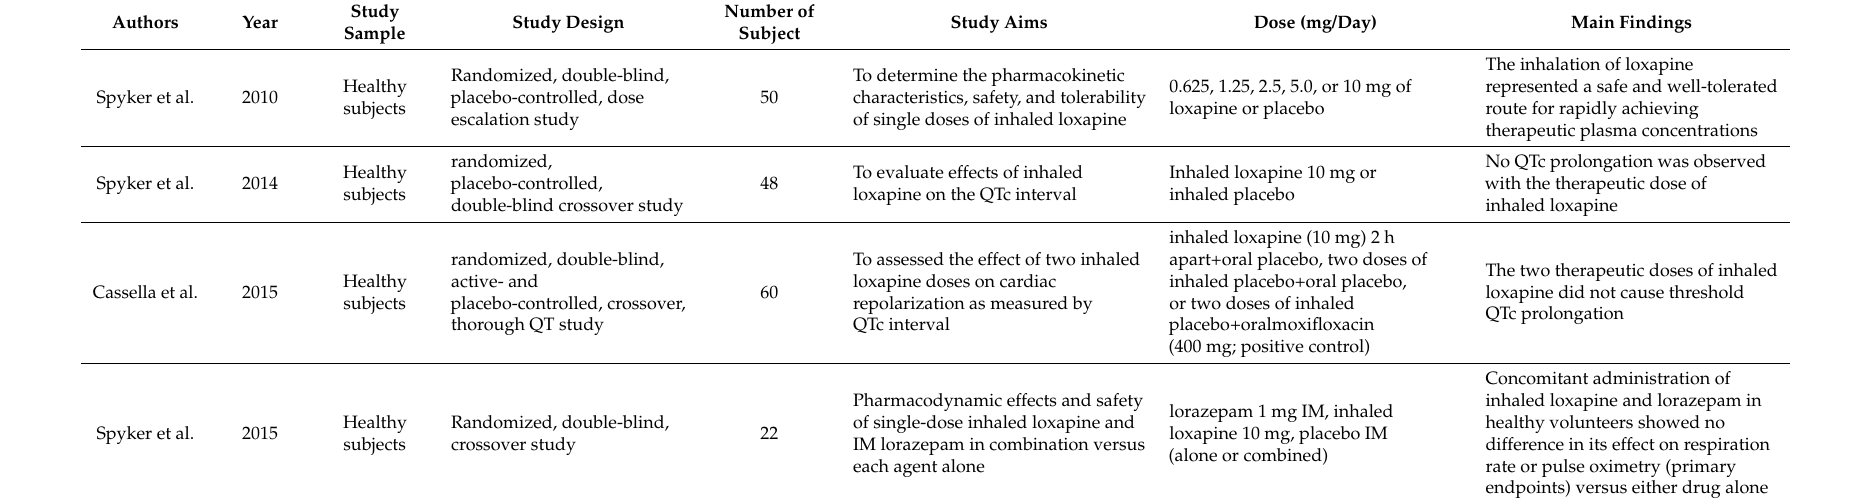
Table 2. Published studies on inhaled FGA loxapine in healthy